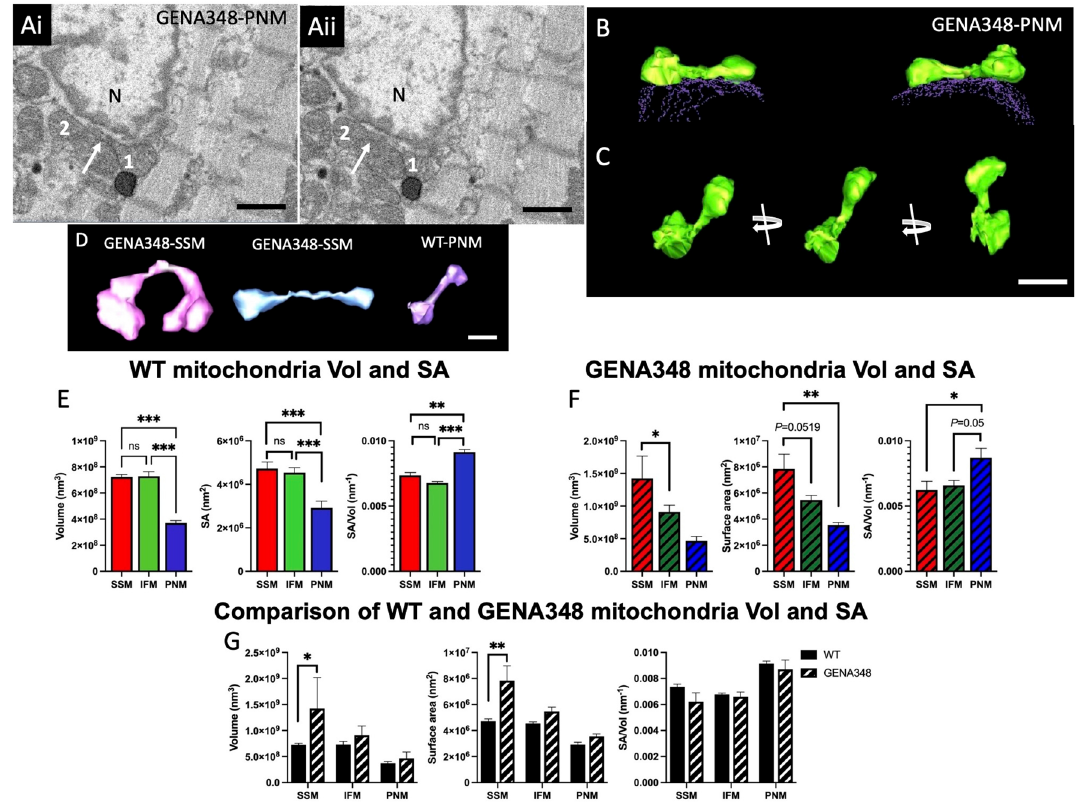
Figure 3. Morphometric analysis of mitochondrial subpopulations in the WT and GENA348 myocardium (apex). ( Ai ) Portion of a serial image showing two mitochondrion (labelled 1 and 2) adjacent to the nucleus, N. The arrow indicates a small projection extending from mitochondrion 1. ( Aii ) Shows the same area but several images (100 nm in Z-direction) further into the SBF-SEM stack showing an extension from mitochondrion 2 (white arrow). ( B ) Segmentation of the two mitochondria labelled 1 and 2 reveals that the projections connect forming a tunnel between the two mitochondria leading to a ‘dumbbell’ shape structure (green isosurface). The nuclear envelope is shown as dashed contours (purple). Portions of each mitochondria and ‘nanotunnel’ are in direct contact with the nucleus. ( C ) Rotation of the 3-D reconstruction of the nanotunnel showing that the tunnel is approximately 1 µm in length. Scale bar = 1 µm. ( D ) Examples of 3-D reconstruction nanotunnels identified in the WT and GENA348 mitochondrial populations. Scale bar = 1 µm. ( E ) Comparison of the WT Vol and SA for each subpopulation determined that PNM are smaller than SSM or IFM, with no difference between SSM and IFM. The SA/Vol ratio of the PNM is greater than SSM or IFM. Mean values (± s.d.) for the WT mitochondrial volumes are; 7.23 ± 0.31 × 10 8 nm 3 (SSM); 7.29 ± 0.59 × 10 8 nm 3 (IFM) and 3.70 ± 0.34 × 10 8 nm 3 (PNM); with a mean SA for each subtype of 4.72 ± 0.31 × 10 6 nm 2 (SSM); 4.54 ± 0.23 × 10 6 nm 2 (IFM); 2.92 ± 0.31 × 10 6 nm 2 (PNM). Data were analysed using a one-way ANOVA (with Tukey’s multiple comparison test) for each mitochondrial subtype from n = 3 animals. * P < 0.05, ** P < 0.01, *** P < 0.001. ( F ) In the GENA348 cardiomyocytes SSM are larger than IFM and PNM (both Vol and SA). Analysis of SA/Vol shows a similar profile to WT mitochondrial subpopulations with PNM having the largest SA/Vol ratio. Mean values (± s.d.) for the GENA348 mitochondrial volumes are; 14.23 ± 3.44 × 10 8 nm 3 (SSM); 9.10 ± 1.02 × 10 8 nm 3 (IFM) and 4.66 ± 1.21 × 10 8 nm 3 (PNM); with a mean SA for each subtype of 7.84 ± 1.13 × 10 6 nm 2 (SSM); 5.46 ± 0.34 × 10 6 nm 2 (IFM); 3.55 ± 0.19 × 10 6 nm 2 (PNM). ( G ) A comparison of the morphometric parameters show GENA SSM are larger than WT. SA/Vol shows no difference between the WT and GENA348 subpopulations. Data analysed using a two-way ANOVA (Sidaks multiple comparison test). Data presented as mean ± SEM; ** P < 0.01, *** P < 0.001, **** P < cristae dimensions or spacing within group subpopulations or when GENA348 cristae were compared with WT, Fig. 6D in keeping with the density analysis. A caveat to both the cristae density and dimension analyses is that only mitochondria with clearly defined cristae, with no areas of cristae loss or disorganization were included. Therefore, a comparison has been made with potentially ‘healthy mitochondria’ within each experimental group. Therefore, we next classified the mito- chondria in the TEM images according to cristae organisation as previously described e.g. 31 . We used an arbitrary scoring rating of 1, 3 and 5 where, 1 = ordered cristae; 3 = partially ordered cristae, and 5 = no discernible cristae respectively (Fig. 6E). WT SSM and IFM have the largest category of type 1 mitochondria whilst for WT-PNM type 3 is the largest group, Fig. 6F. In contrast, there are less of type 1, with more type 3 and type 5 mitochondria (i.e. more mitochondria with disordered cristae) in the GENA348 SSM and PNM subpopulations. GENA348